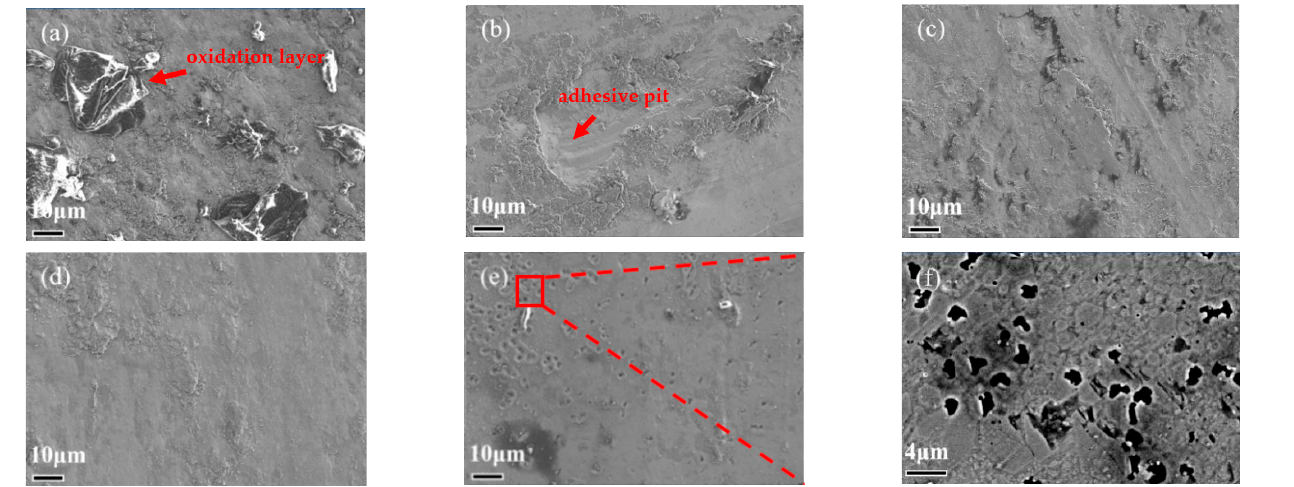
Figure 9. SEM morphology of grinding pin surfaces prepared using the same process and different Cr 3 C 2 content: ( a ) 0 wt.%, ( b ) 5 wt.%, ( c ) 15 wt.%, ( d ) 25 wt.%, and ( e , f ) 35 wt.%.